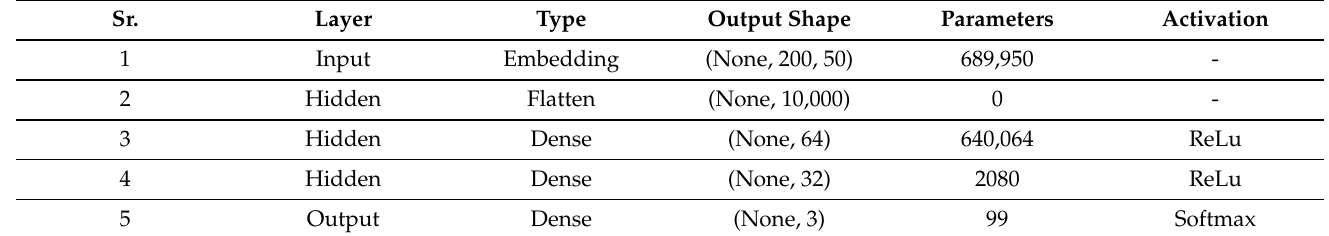
Table 8. Model summary of the fine-tuned feed-forward neural network.